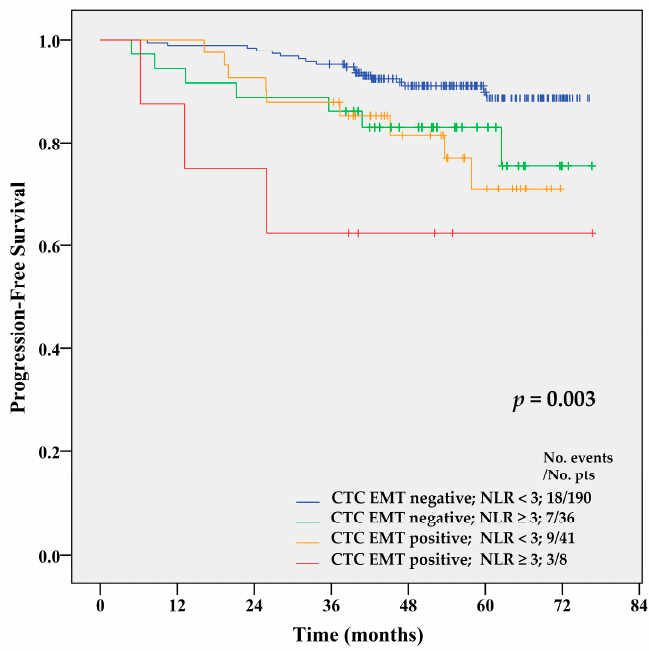
Figure 3. Kaplan–Meier PFS estimates for combinations of CTC EMT and NLR index. CTC EMT-positive patients with NLR ≥ 3 had shorter PFS compared to patients with any other combination of CTC EMT and NLR ( p = 0.003 by Log-rank test).